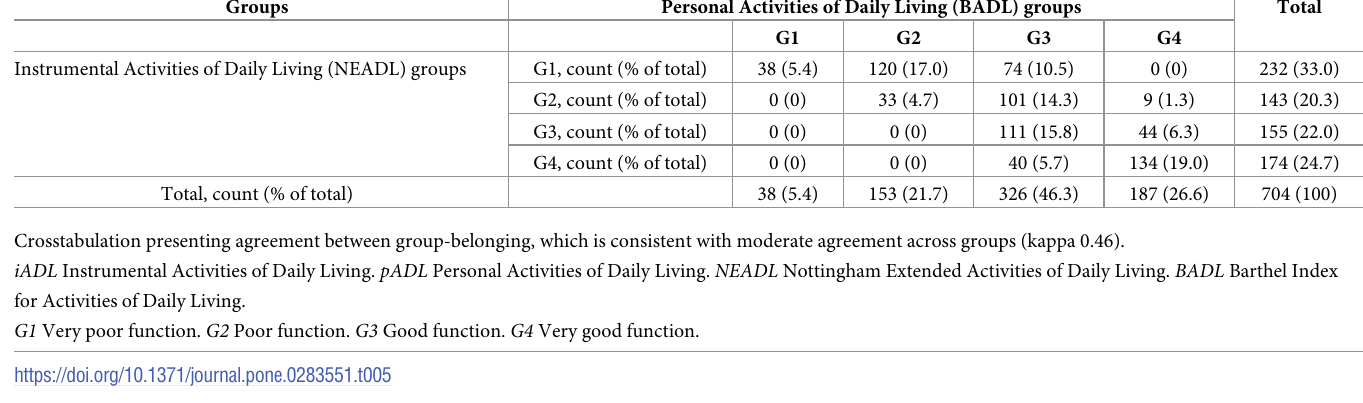
a one-point difference in BADL distinguishes being independent or dependent in certain cally relevant decline in ADL the first year after a hip fracture. Due to the higher complexity of iADL tasks, it is not unusual that patients first experience deterioration iADL and then in pADL, which might explain the kappa agreement of 46% in our analysis. For all iADL and pADL trajectories, the functional decline was steepest the first four months after the fracture, with no functional recovery between four and 12 months. Whether it is because the participants had reached their maximum rehabilitation potential, or because the rehabilitation offered concluded prematurely, remains to be explored [34]. Nevertheless, these trajectories may represent different groups of patients with different rehabilitation needs, and a need for more personalized rehabilitation, especially in early phases when discharge are planned and during the first months after the hip fracture. Table 5. Crosstabulation between iADL and pADL groups.